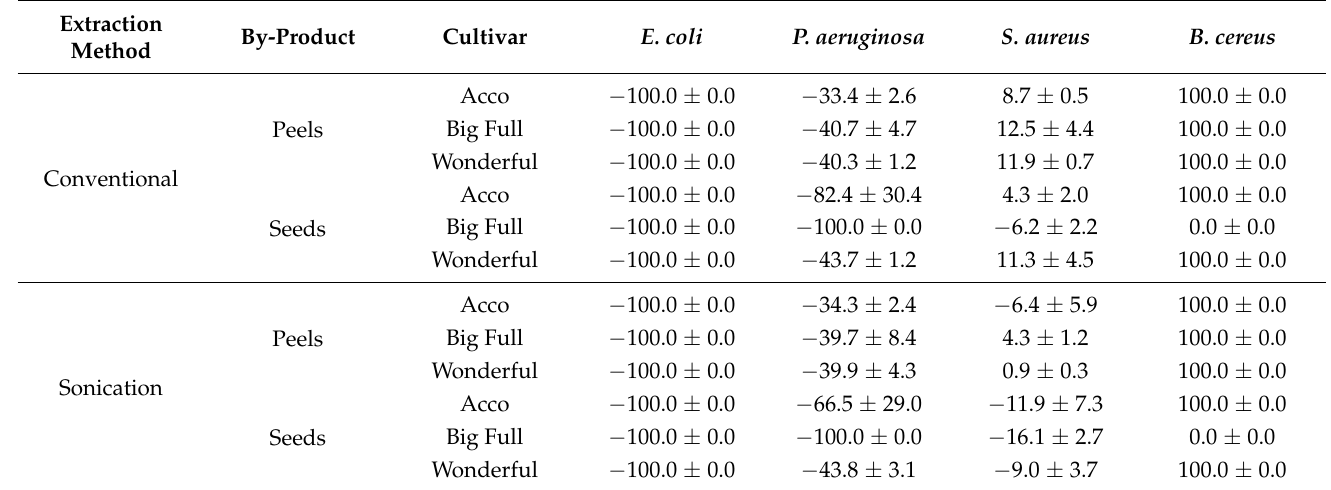
Table 7. Antimicrobial activity index (%) for peels and seeds extracts of Acco, Big Full, and Wonderful cultivars, from both extractions, relative to penicillin.